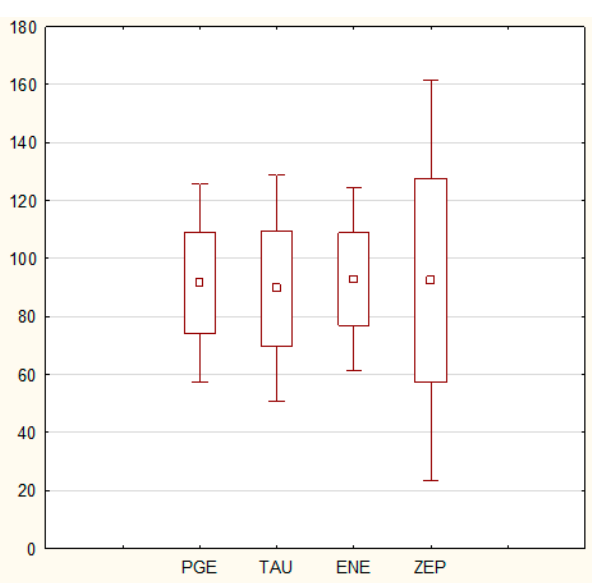
Figure 13. Box plot for quotation changes. Source: Own